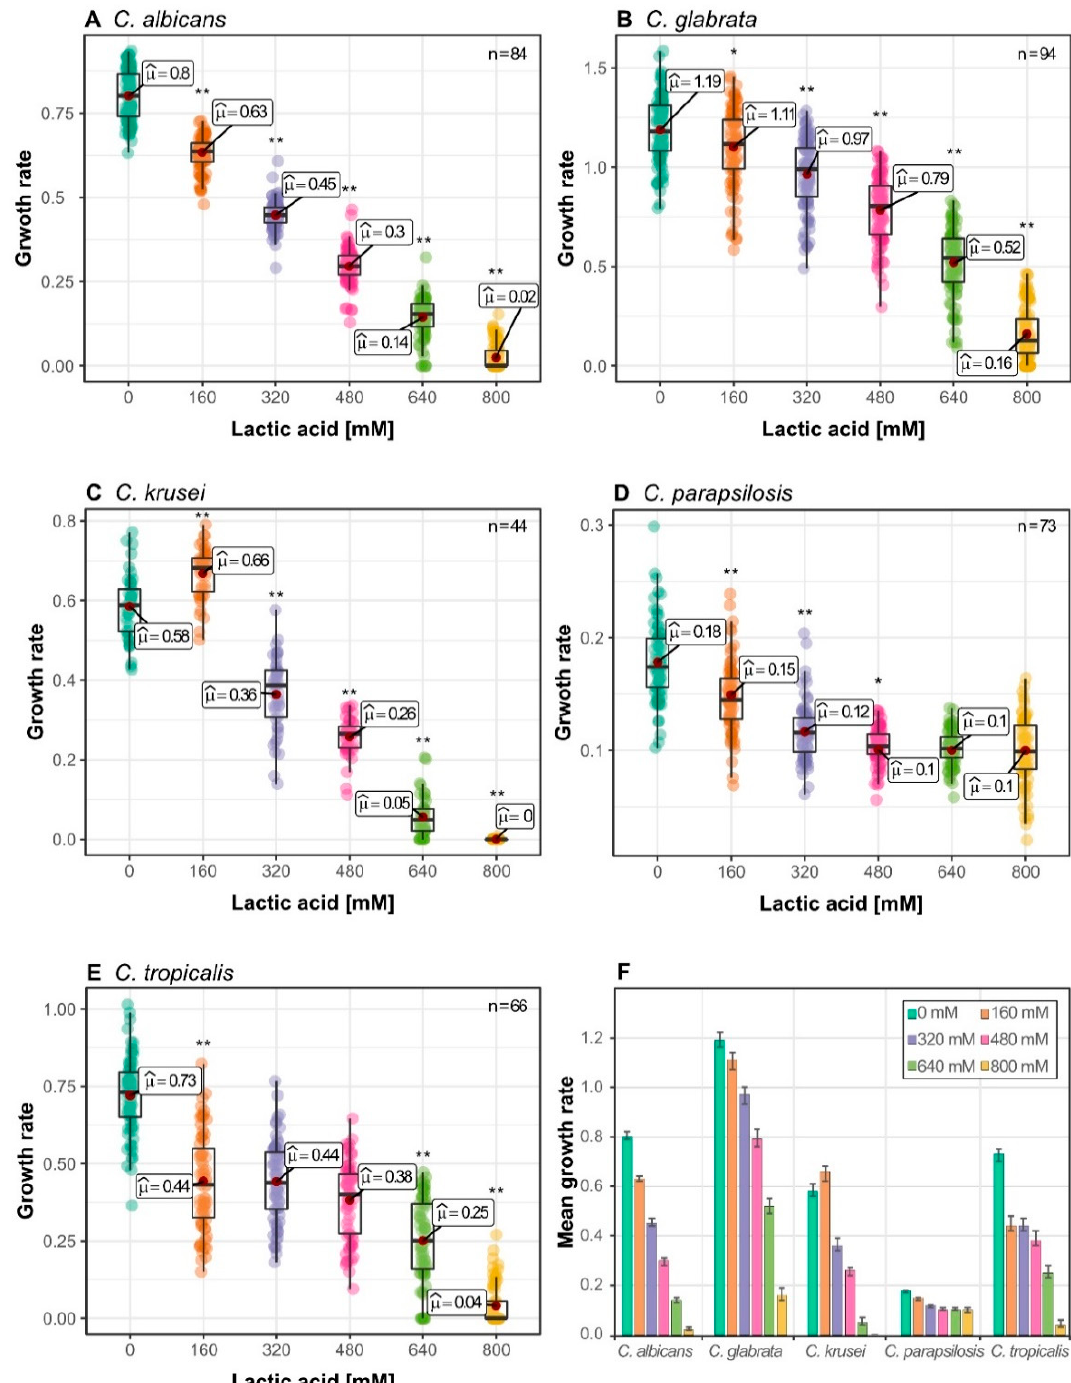
Figure 1. Growth of di ff erent Candida species under lactic acid stress with 2% Glucose as carbon source: ( A ) C. albicans ; ( B ) C. glabrata ; ( C ) C. krusei ; ( D ) C. parapsilosis ; ( E ) C. tropicalis ; ( F ) Mean growth rates of di ff erent Candida species to lactic acid stress, Error bars represent confidence interval of 95%; Each data point represents mean growth rate of triplicates measurements; Asterisks represents statistical di ff erence of one condition to the next lower lactic acid concentration (* p ≤ 0.05, ** p ≤ 0.001). Raw data can be found in Supplementary Table S2